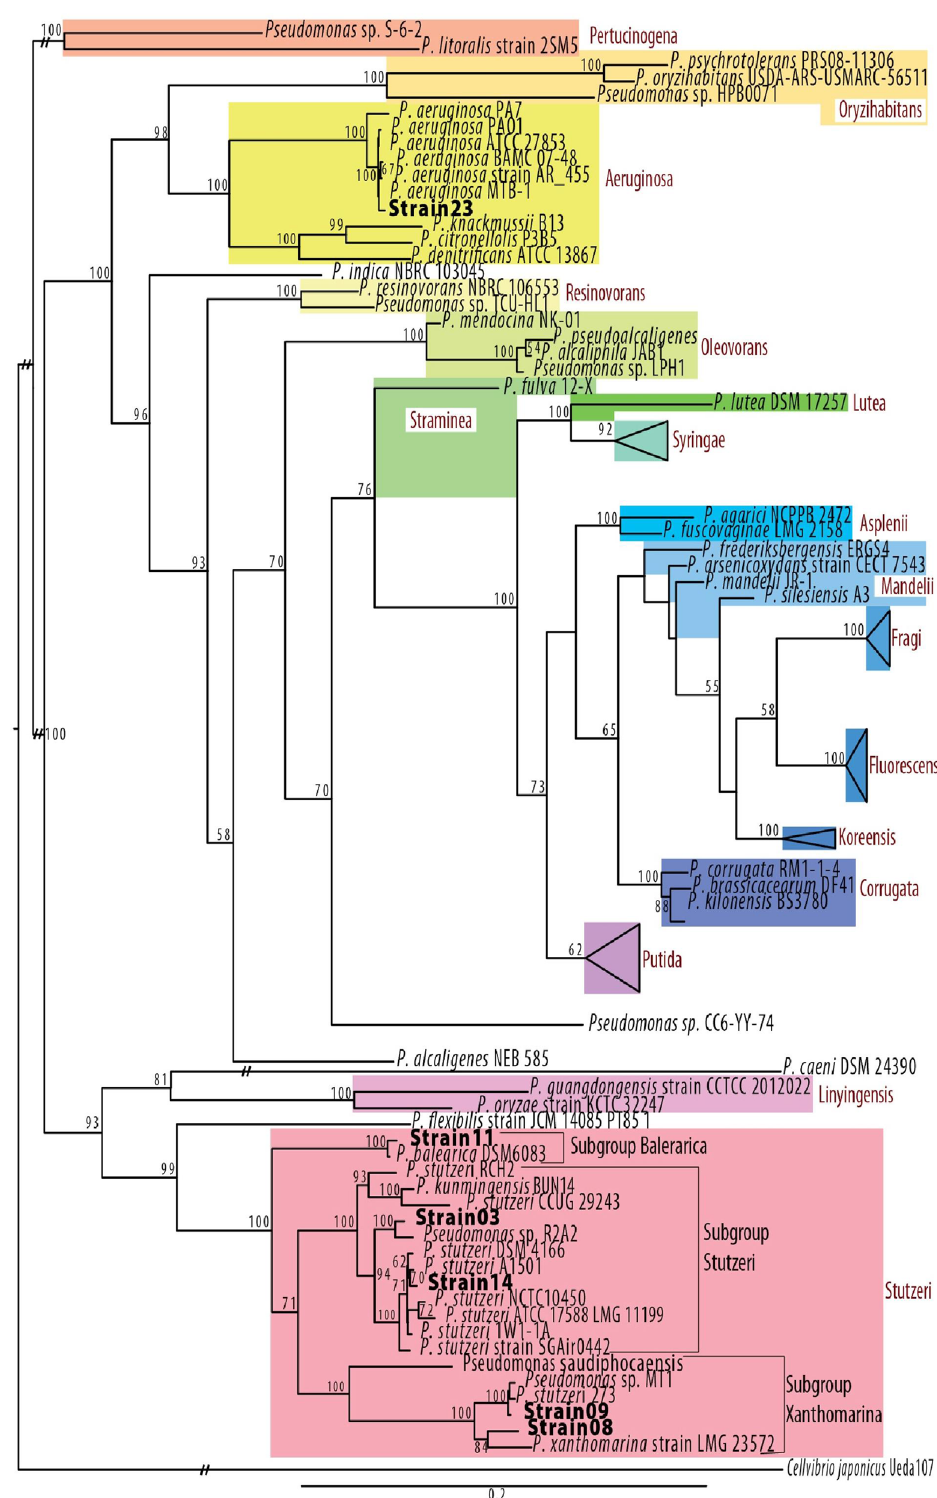
Figure 4. Phylogenetic analysis of Pseudomonas strains. Maximum Likelihood topology of Pseudomonas genus based on the concatenation of 10 conserved proteins with 1000 bootstraps. A total of six strains, representing each of the six subgroups, were used in the tree construction i.e. strains 23, 11, 03, 14, 09, 08. Support values greater than 50% are indicated on the tree. Bar represents 0.2 amino acid substitutions per site. Sequences determined here are indicated in bold. Cellvibrio japonicus Ueda107 was used as outgroup. Each clade is colorated based on the group in which it belongs, while the name of the group is indicated in red. Branches with the “//” symbol have been truncated for presentation